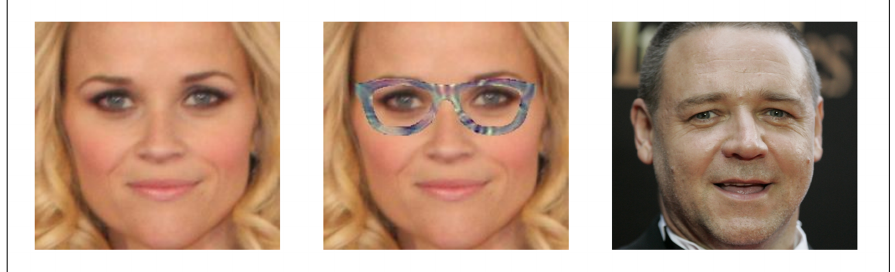
Figure 13. An impersonation using frames. Left: Actress Reese Witherspoon [85]. Image classified correctly with probability 1. Middle: Perturbing frames to impersonate (actor) Russel Crowe. Right: The target [86] (Image Credit: Sharif et al.